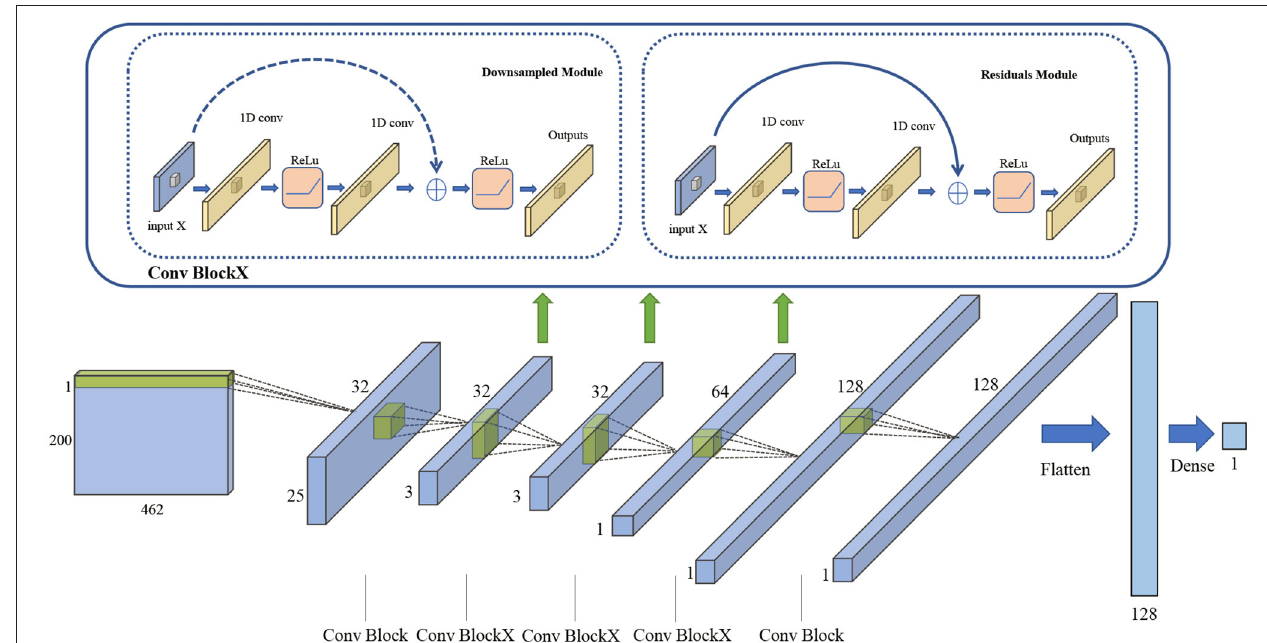
FIGURE 4 | Con1dResNet network structure schematic.